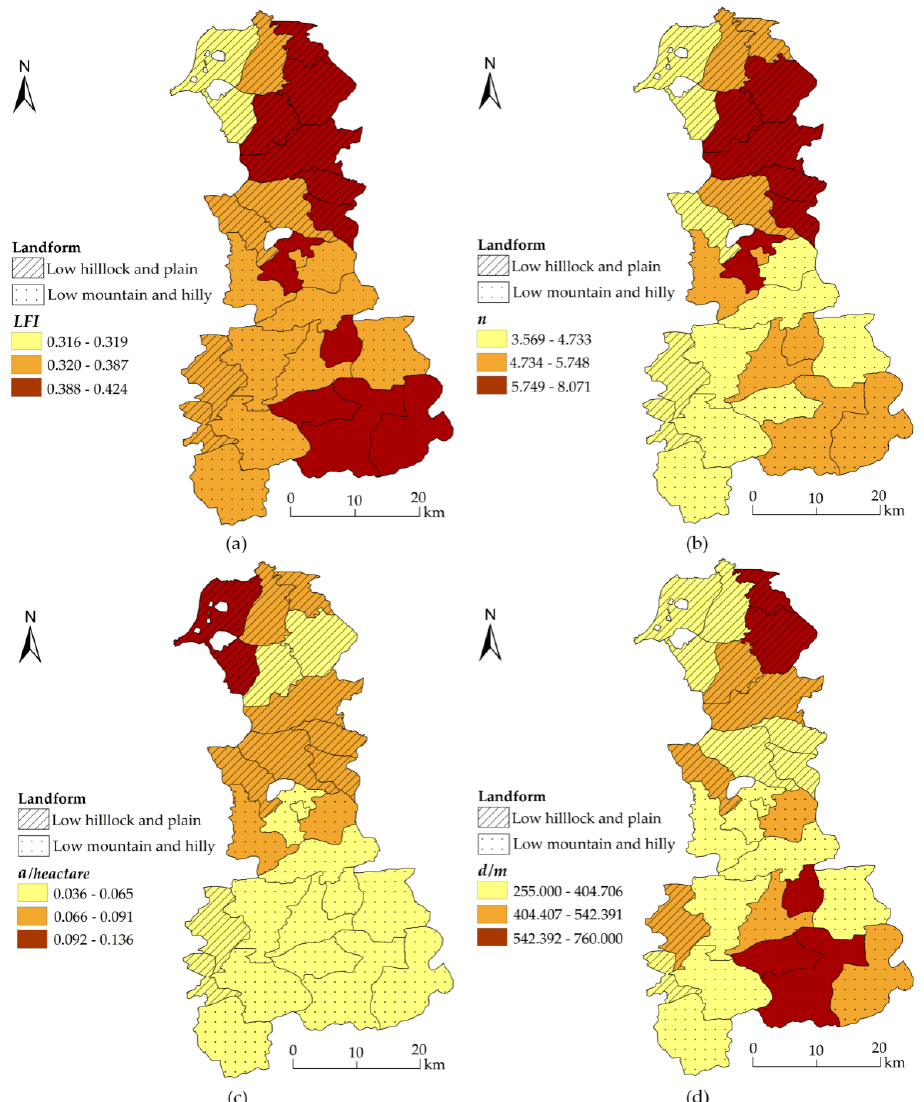
Figure 2. Spatial distribution of LF degree in different landform types: ( a ) the average LFI; ( b ) the average number of plots; ( c ) the average size of plots; ( d ) the average distance between plots.